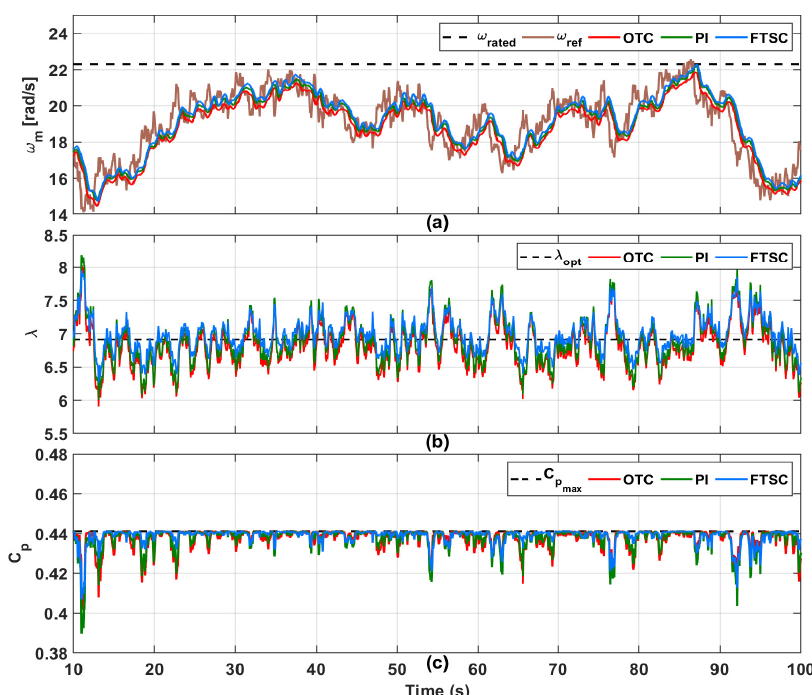
Figure 22. Experimental results for dynamic response comparison of PMVG-based WECS for varying wind profile case-I . ( a ) Rotor speed. ( b ) Tip speed ratio. ( c ) Power coefficient under proposed control system in comparison with OTC and PI control methods.